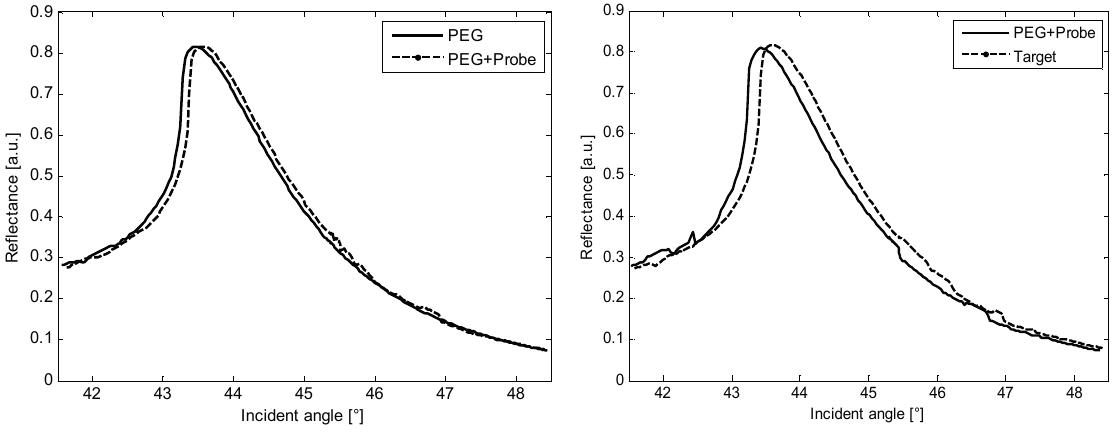
Figure 5. SPR responses; each measurement refers to two adjacent wells (Figure 1). Left : the plasmon resonance of the palladium + PEG has been compared to the response of palladium +PEG + probe; Right : the plasmon resonance of the palladium + PEG + probe has been compared to the response of the